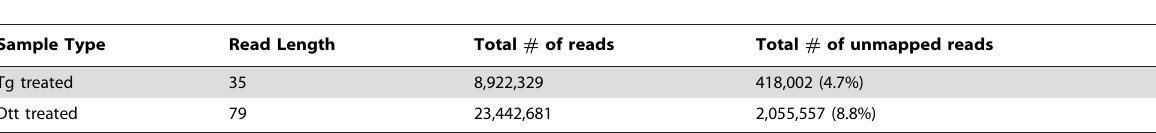
Table 1. Bowtie Mapping statistics for Ire1 a + / 2 samples treated with Tg and Dtt.